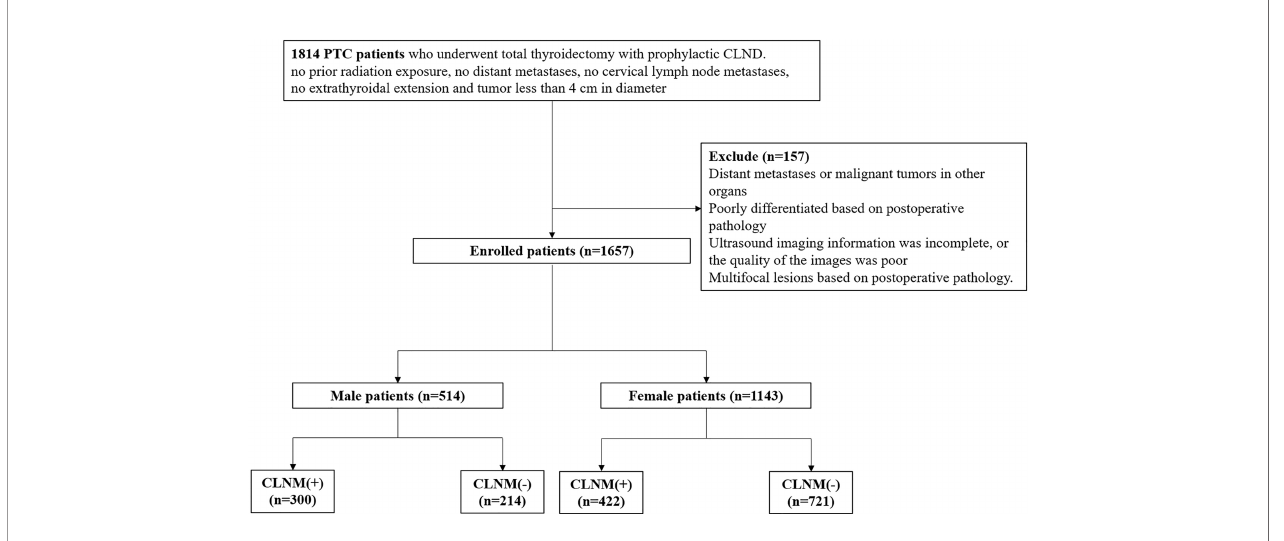
FIGURE 1 | Flow chart of the patients enrolled in our